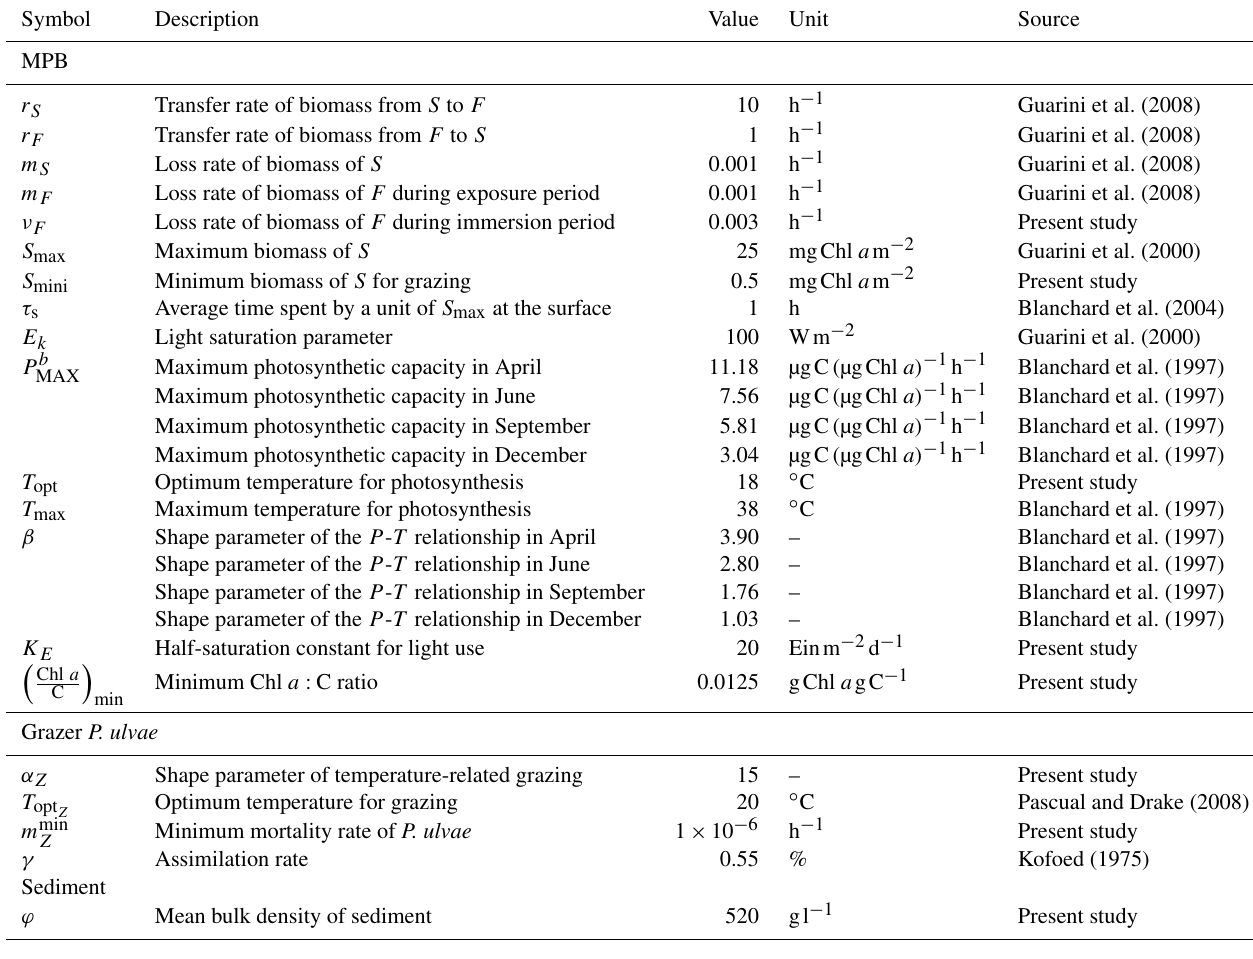
Table B1. Biological model parameters.